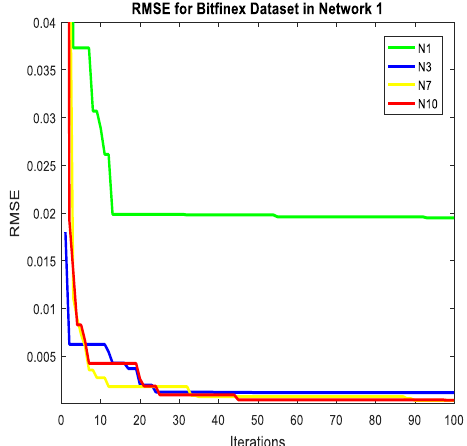
Figure 9. Fitness plot for Bitfinex dataset.